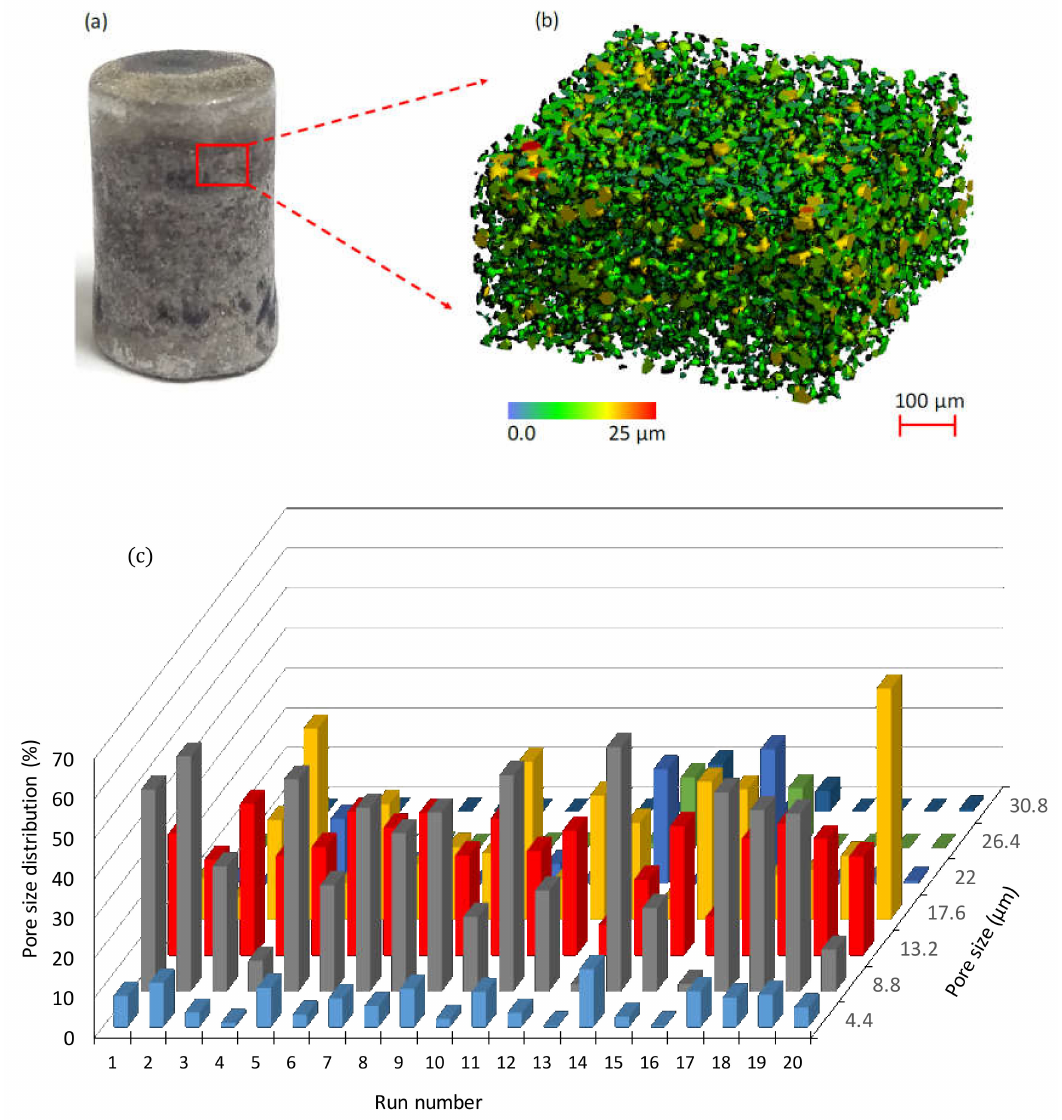
Figure 5. ( a ) The microwave sintered (representative) cylindrical component for micro-CT; ( b ) 3D reconstruction of the pores in a volume of 550 µ m × 300 µ m × 500 µ m; and ( c ) pore size distribution of the sintered titanium